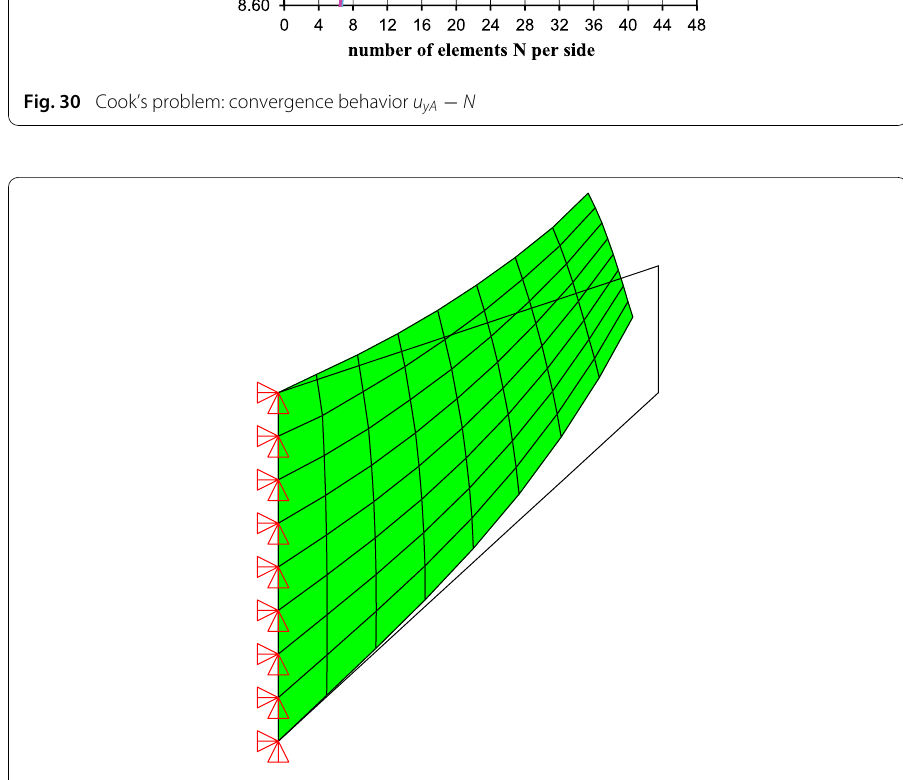
Fig. 31 Cook’s problem: deformed mesh for P =